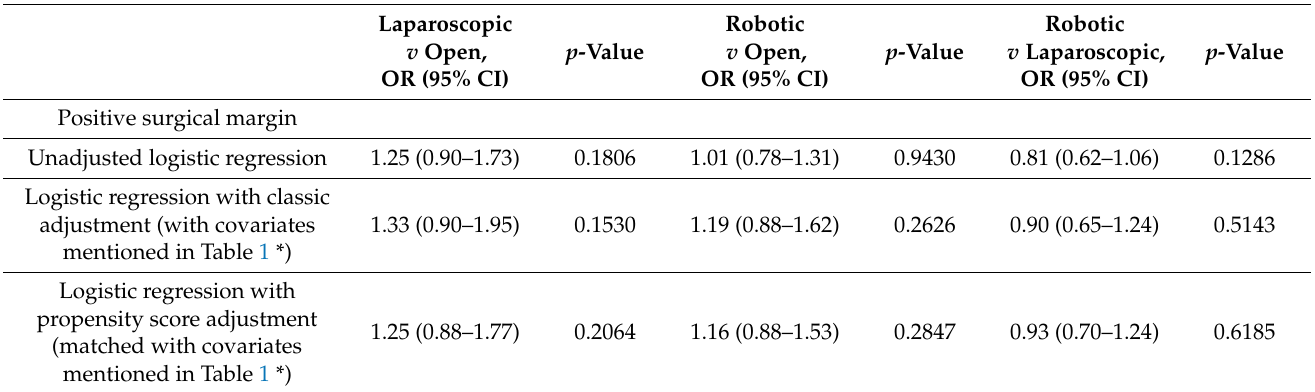
Table 3. Logistic Regression Analysis of Positive Surgical Margin by Surgical Modality.